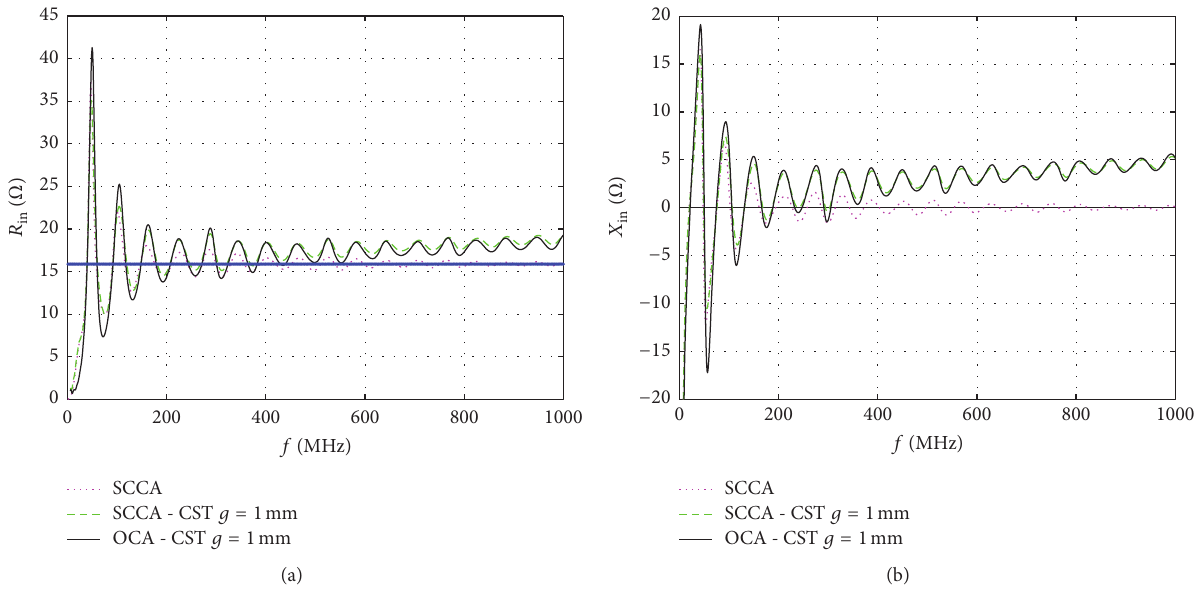
Figure 13: 𝑍 of the theoretical SCCA and the CST simulated SCCA and OCA for 𝜃 0 = 75 ∘ : (a) 𝑅 in